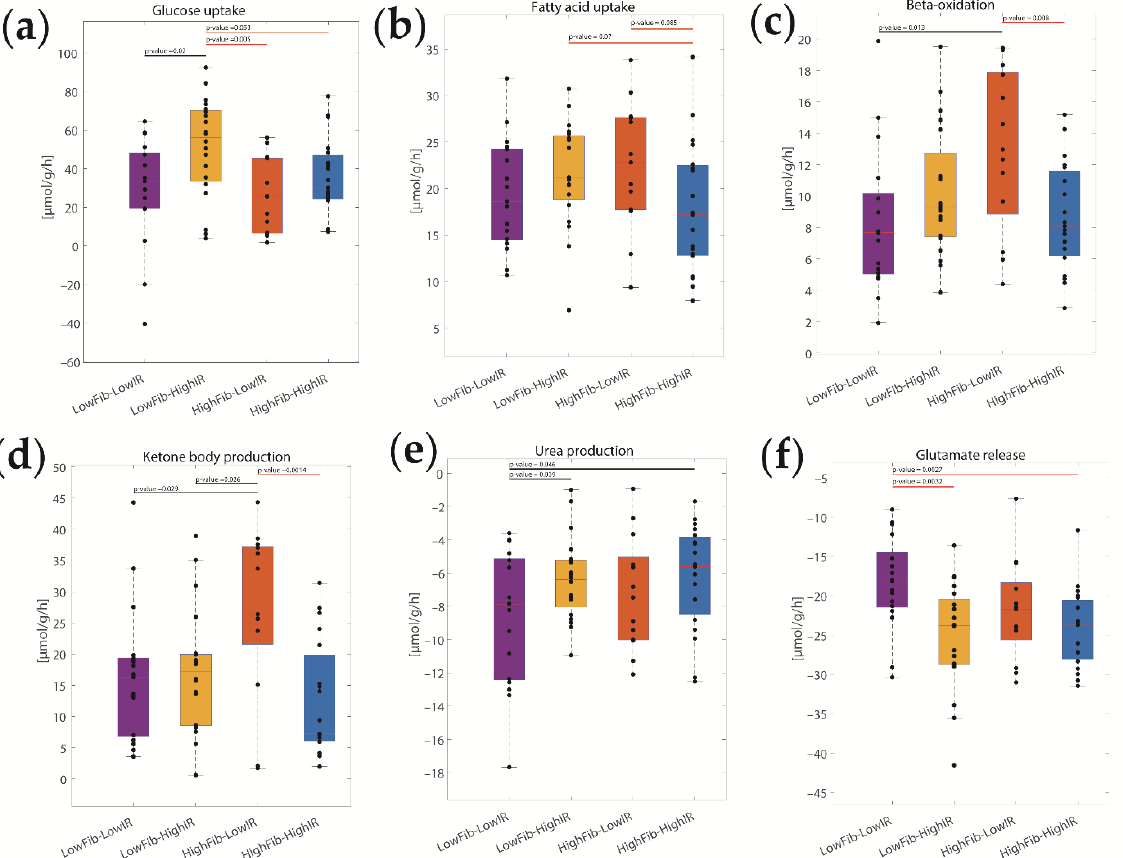
Figure 6. Diurnal differences in metabolic functions between the four disease classes (variant A) defined by the degree of fibrosis and HOMA-IR. ( a ) Rate of glycolysis; ( b ) Fatty acid uptake; ( c ) β -oxidation; ( d ) Ketone body production; ( e ) Urea production; ( f ) Glutamate release. Crossbars indicate differences between groups based on two-sided t -testing (orange: p < 0.1; black: p < 0.05; red: p < 0.01). Corresponding p -values are given above bars.